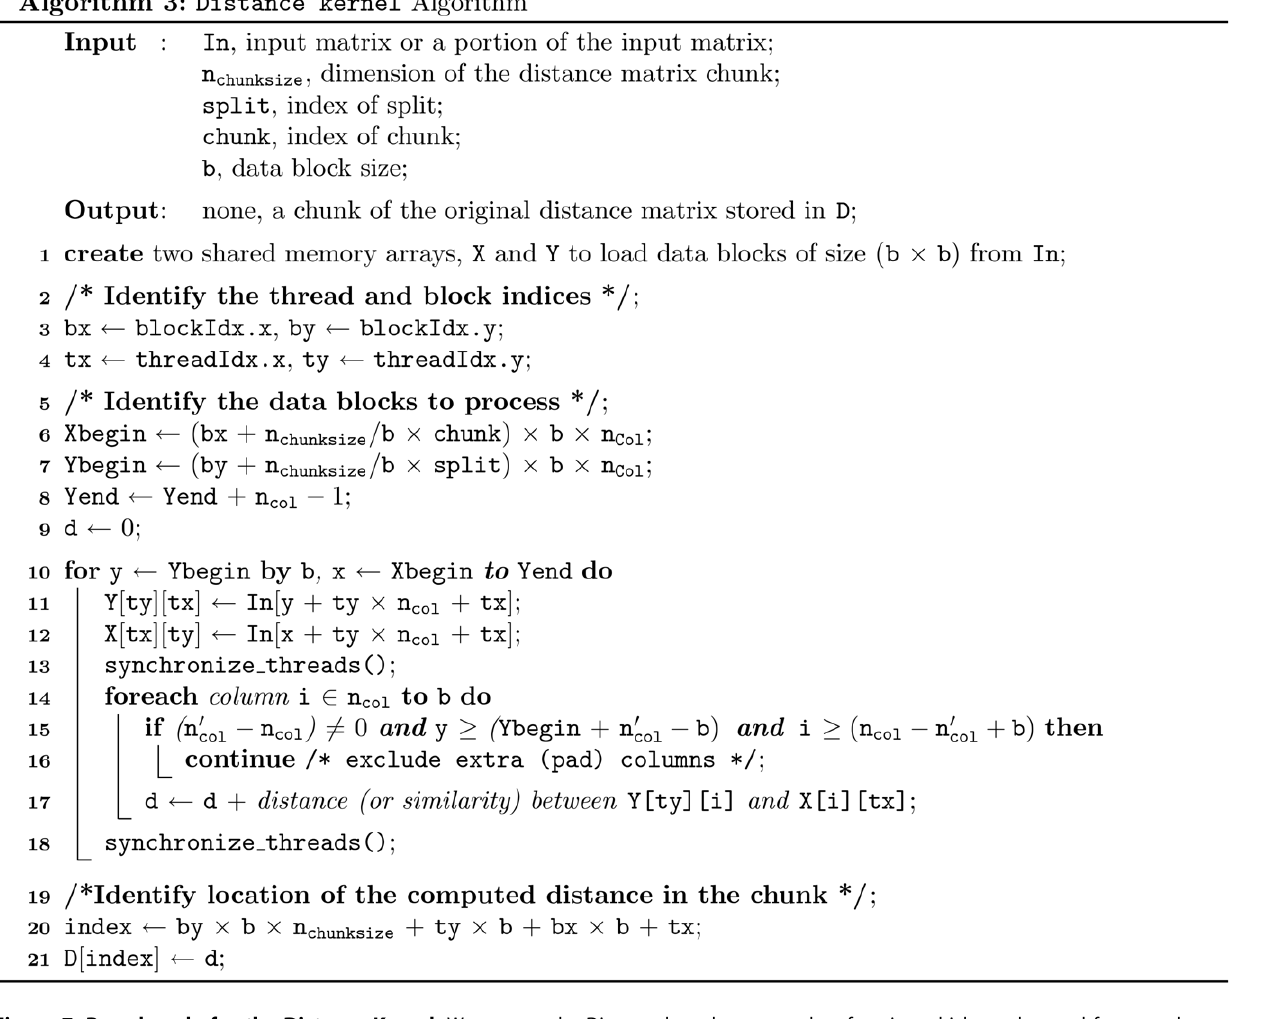
Figure 7. Pseudocode for the Distance Kernel. We present the Distance kernel as a template function which can be used for several types distance measures (such as Euclidean or Manhattan distance etc.) or similarity measures (such as Pearson’s correlation). Here, one thread is responsible for computing a single distance. The threads are organized as a set of two dimensional blocks and grids. Although the algorithm and the thread organization are adapted from Chang et al. [23,24], we modified them to compute a chunk of the distance matrix instead of the complete distance matrix.